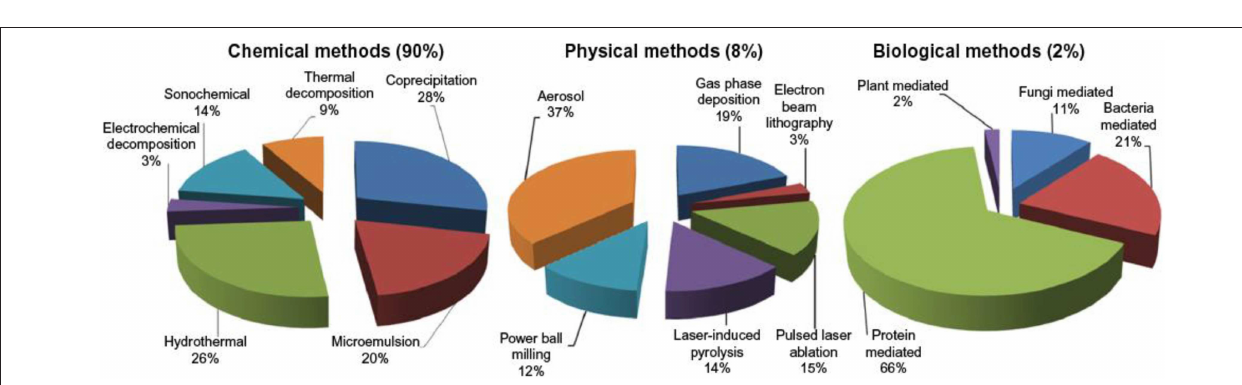
FIGURE 3 | Comparative presentation of the synthesis of iron oxide magnetic nanoparticles by three different routes [adapted and modified from Ali et al.